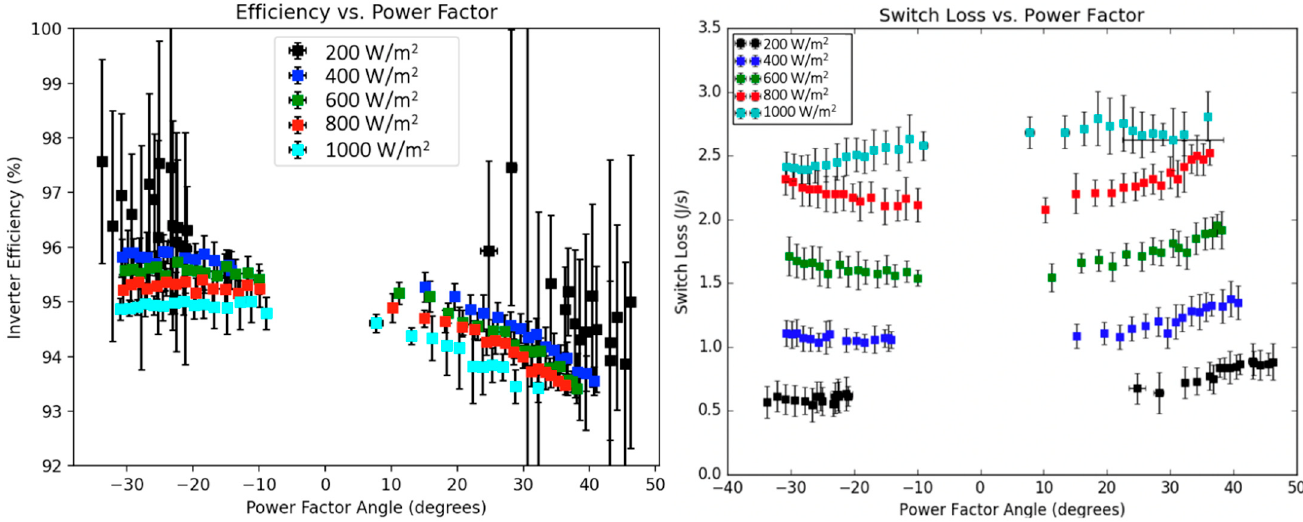
Figure 8. PV inverter losses for a range of PV irradiance levels and power factors. ( left ) System efficiency vs. power factor angle. ( right ) switch loss vs. power factor angle.